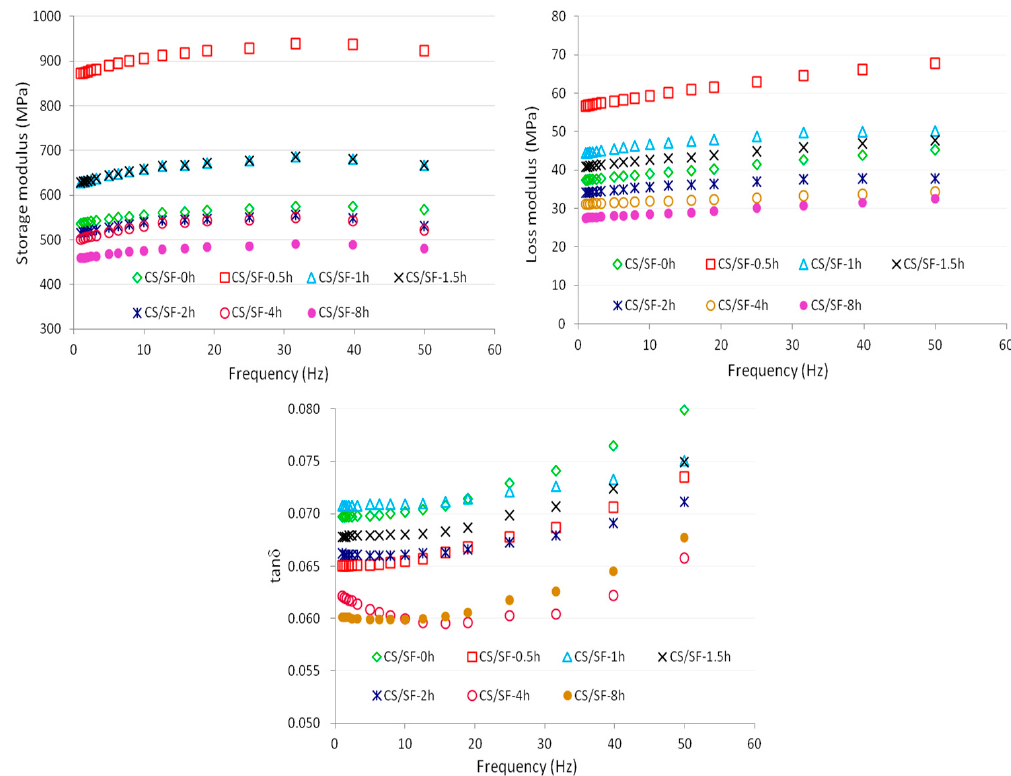
Figure 2. Storage modulus, loss modulus, and tan δ versus frequency curves of the corn straw starch-based films (CS/SFs) with different ball grinding times.